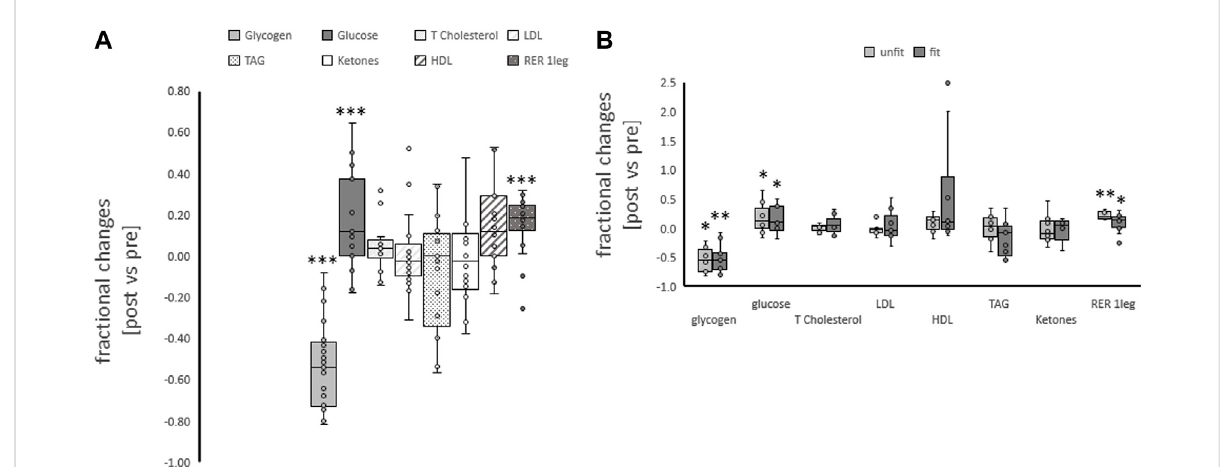
FIGURE 1 Metabolic changes with one-legged exercise. Box-Whisker plots (box: fi rst and third quartile, whisker minima and maxima, line: median, x: mean, circles: non overlapping data points) for the fractional changes for blood metabolites and respiration exchange ratio immediately post one- legged exercise, and muscle glycogen concentration 30 min post one-legged exercise combined (A) and split for aerobic fi tness state (B) . *, **, *** p < 0.05, < 0.01, < 0.005, respectively, for signi fi cant post vs. pre differences. ANOVA for the repeated factor of exercise and the factor of aerobic fi tness. N = 27.